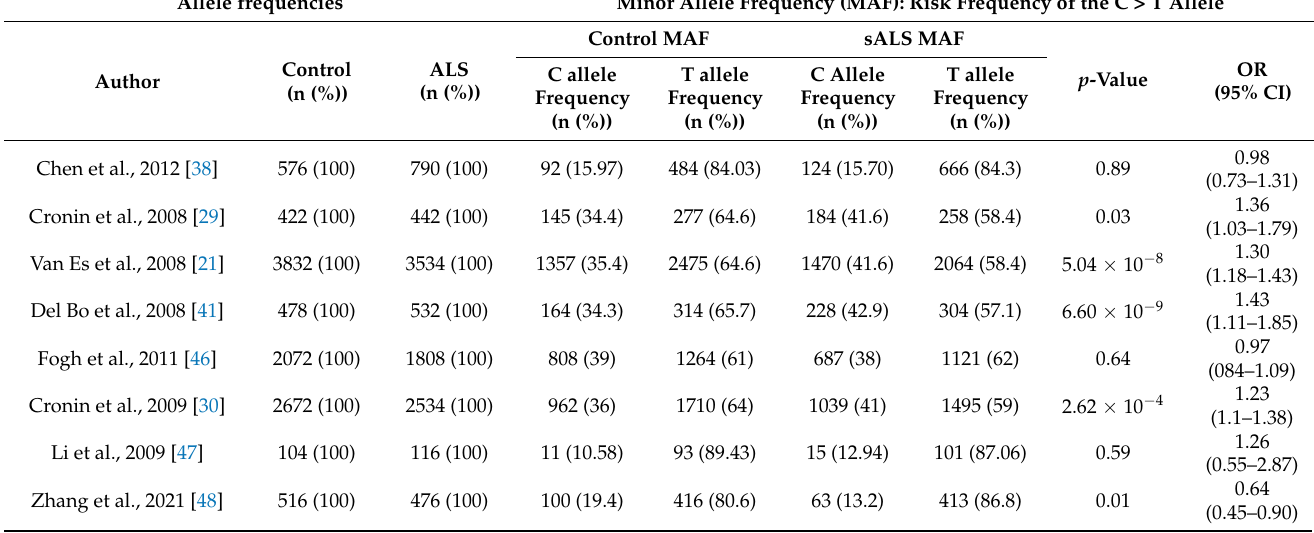
Table 3. Characteristics of the studies included in the meta-analyses. Risk of minor allele frequencies (C allele) and p -values for studies of variant SNP rs10260404 within the DPP6 gene between the SALS group and control